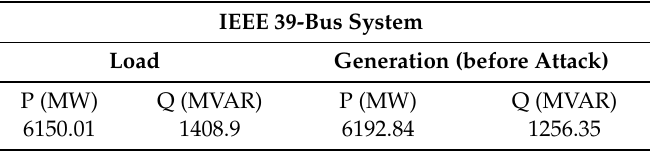
Table 6. Load and generation data of the IEEE 39-bus system.